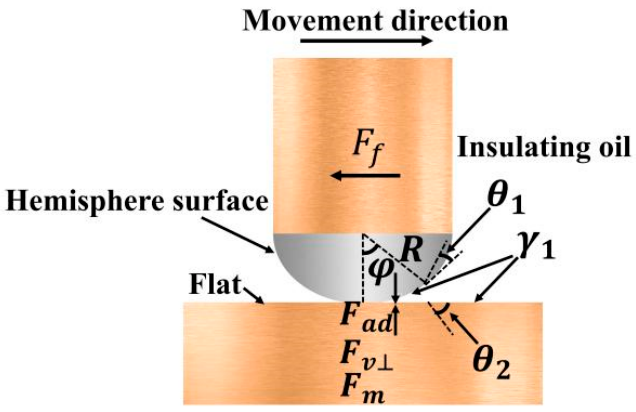
Figure 9. Force analysis diagram of contact couple in insulating oil. Table 5. Explanation of terms in Figure 9 and meanings of some parameters in the following formula. Parameters Meaning Angle between insulating oil and copper contact surface The half-angle of the contact area